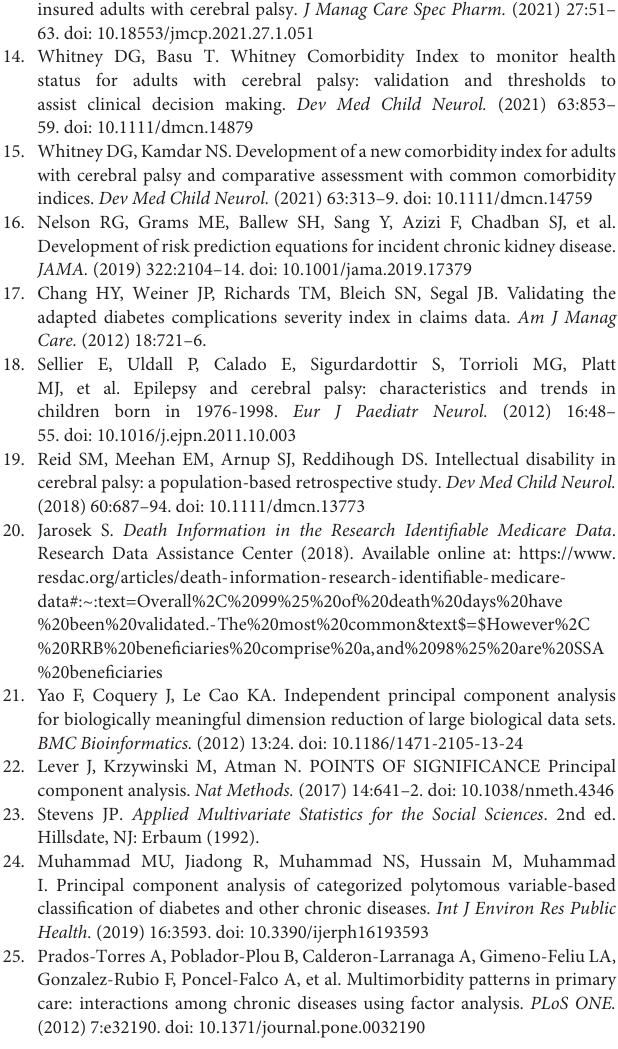
Supplementary Figure 2 | Principal component analysis among 3,798 adults with cerebral palsy with co-occurring epilepsy and intellectual disabilities. (A) Principal components (PC) represent the comorbidity combinations in order of the amount of variance percent (VP) explained and the cumulative VP (CVP) explained. ∗ P < 0.05 for the association of that PC with 2-year mortality. (B) The association between each PC with 2-year mortality after PC scores were transformed into quintiles to facilitate comparisons across PCs (reference: lowest quintile). The bars represent the hazard ratio (HR) and the vertical lines represent the 95% confidence interval (CI) for 2-year mortality after adjusting for all PCs, age, sex, race, and U.S. region of residence. The dotted horizontal line represents a HR of 1.0. If the 95% CI crosses the dotted line, the association is not statistically significant at P =